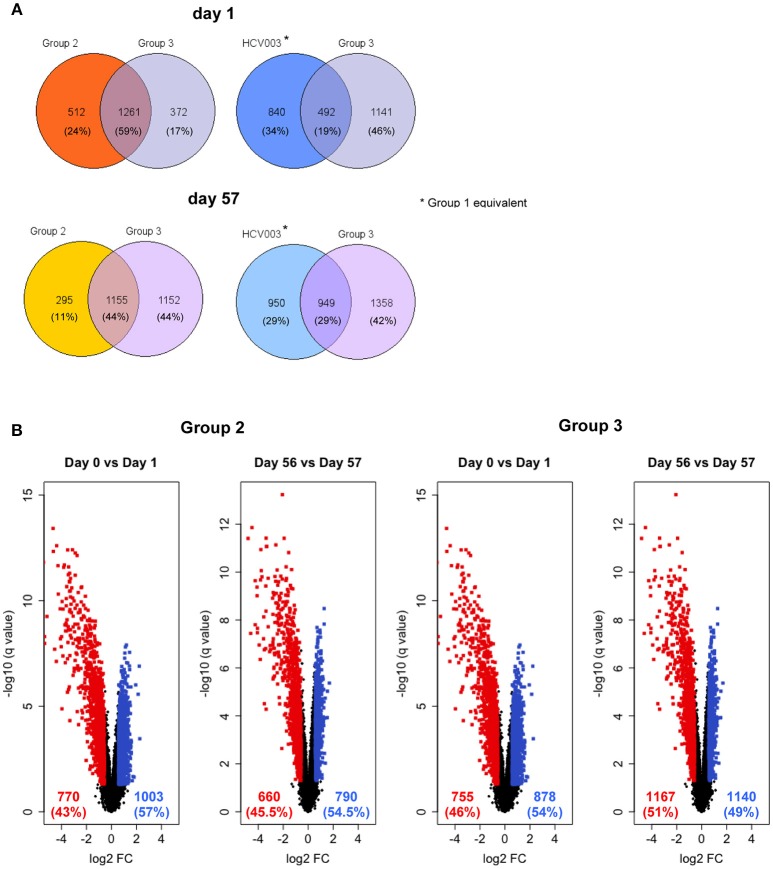
(A) Venn diagrams showing the proportion of genes that were significantly differentially expressed on days 1 and 57, i.e., 24 h post-prime and post-boost vaccination, respectively, with data from the HCV003 trial participants (ChAd3-NSmut/MVA-NSmut, L. Swadling, personal communication) included for comparison with Groups 2 and 3. (B) Volcano plots illustrate the numbers of the differentially expressed genes 24 h after vaccination. Red dots—genes significantly downregulated; blue dots—significantly upregulated).